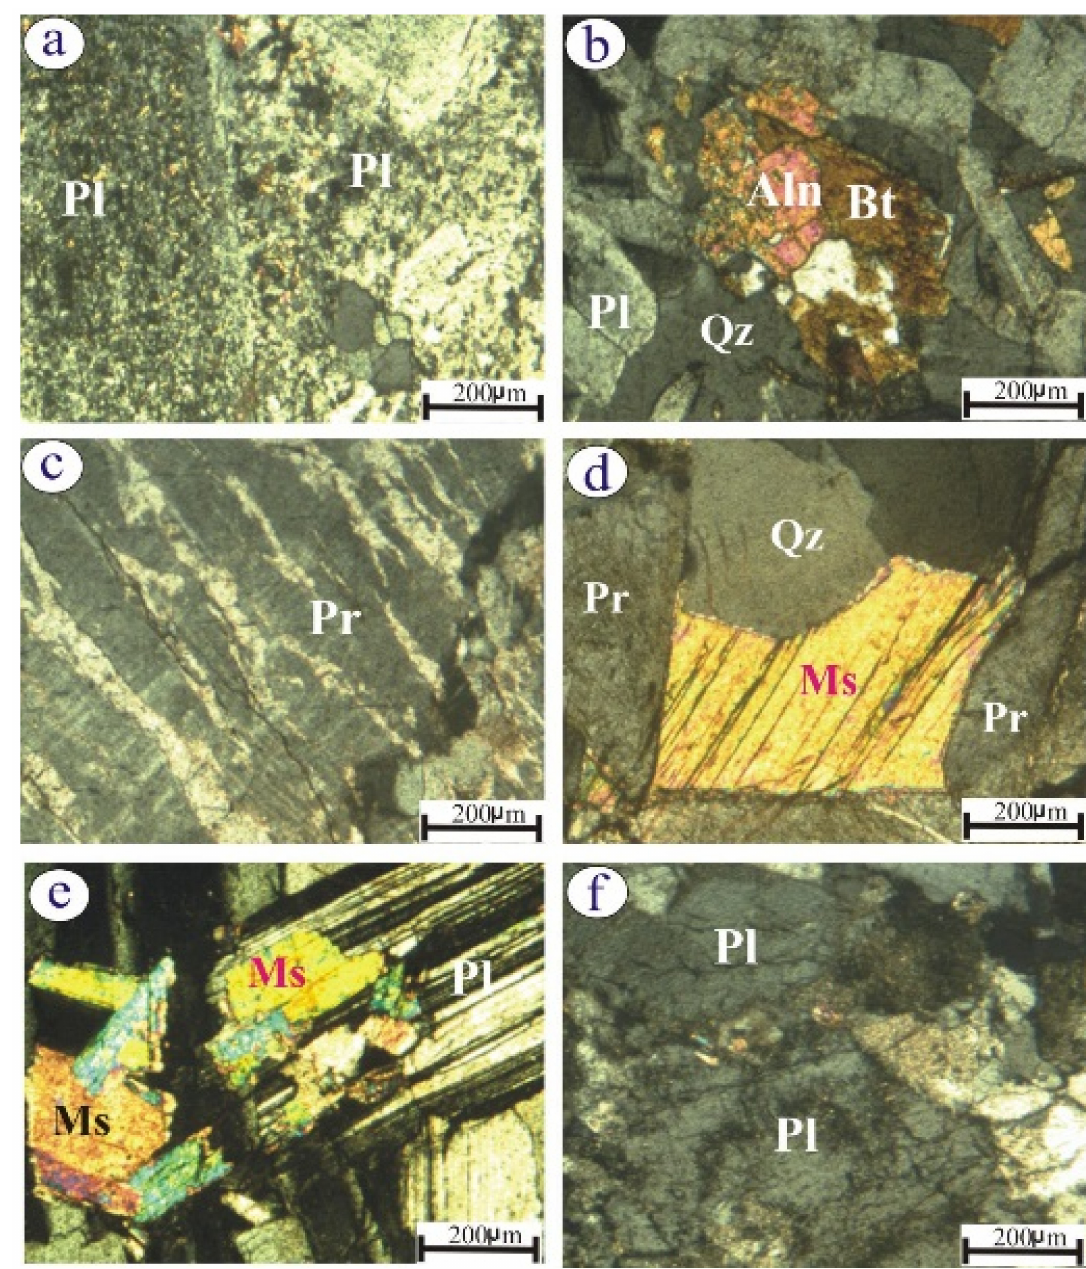
Figure 3. Crossed-polar photomicrographs showing ( a ) Extensive plagioclase saussiritization (Pl) in tonalite; ( b ) Allanite (Aln) associated with biotite (Bt) crystals in granodiorite; ( c ) Pristine patchy perthite (Pr) in syenogranite; ( d ) Coarse-grained muscovite (Ms) associated with perthite and quartz (Qz) in alkali-feldspar granites; ( e ) Coarse-grained plagioclase engulfing fine-grained muscovite in alkali-feldspar granites; and ( f ) Turbid albite plagioclase crystals in albitite